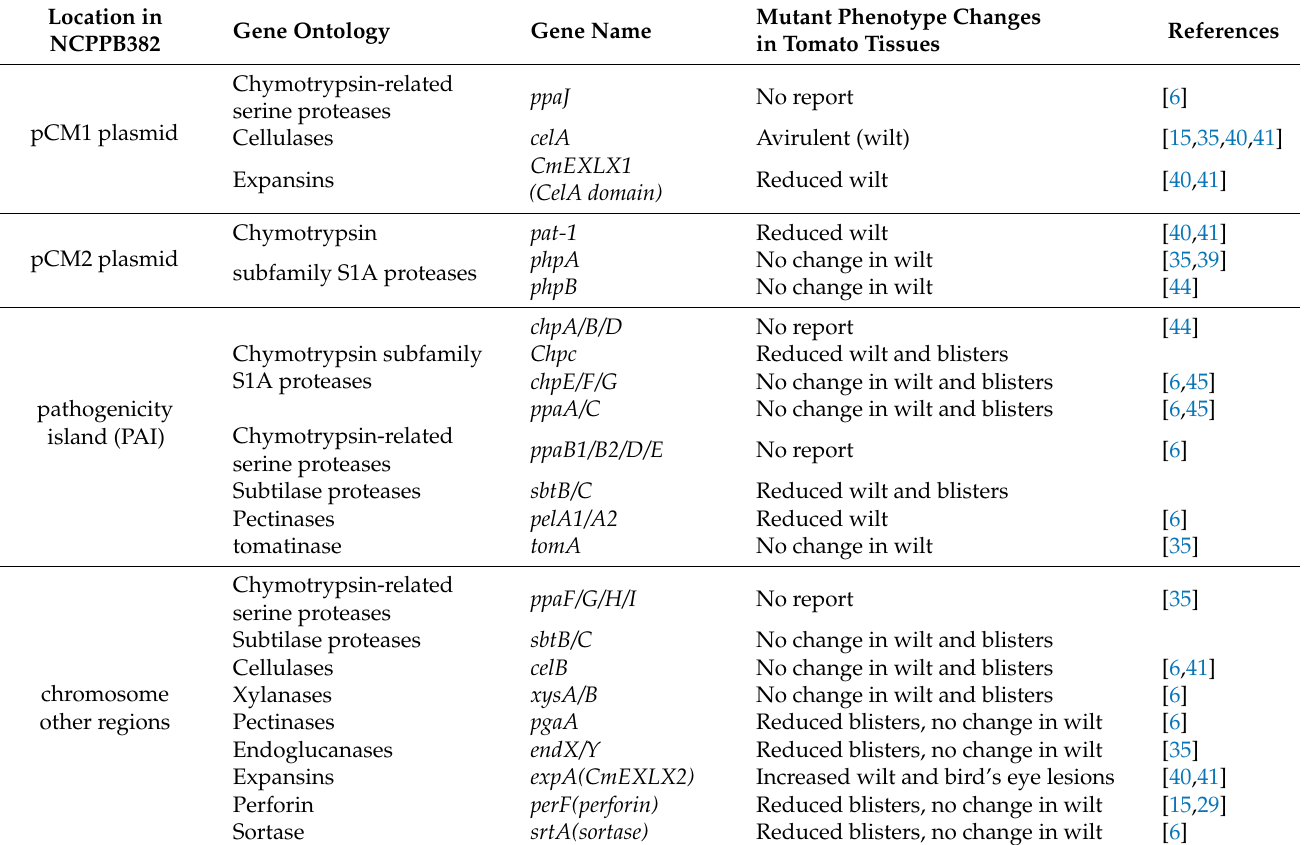
Table 1. Putative virulence genes and changes in disease phenotypes resulting from mutations to individual